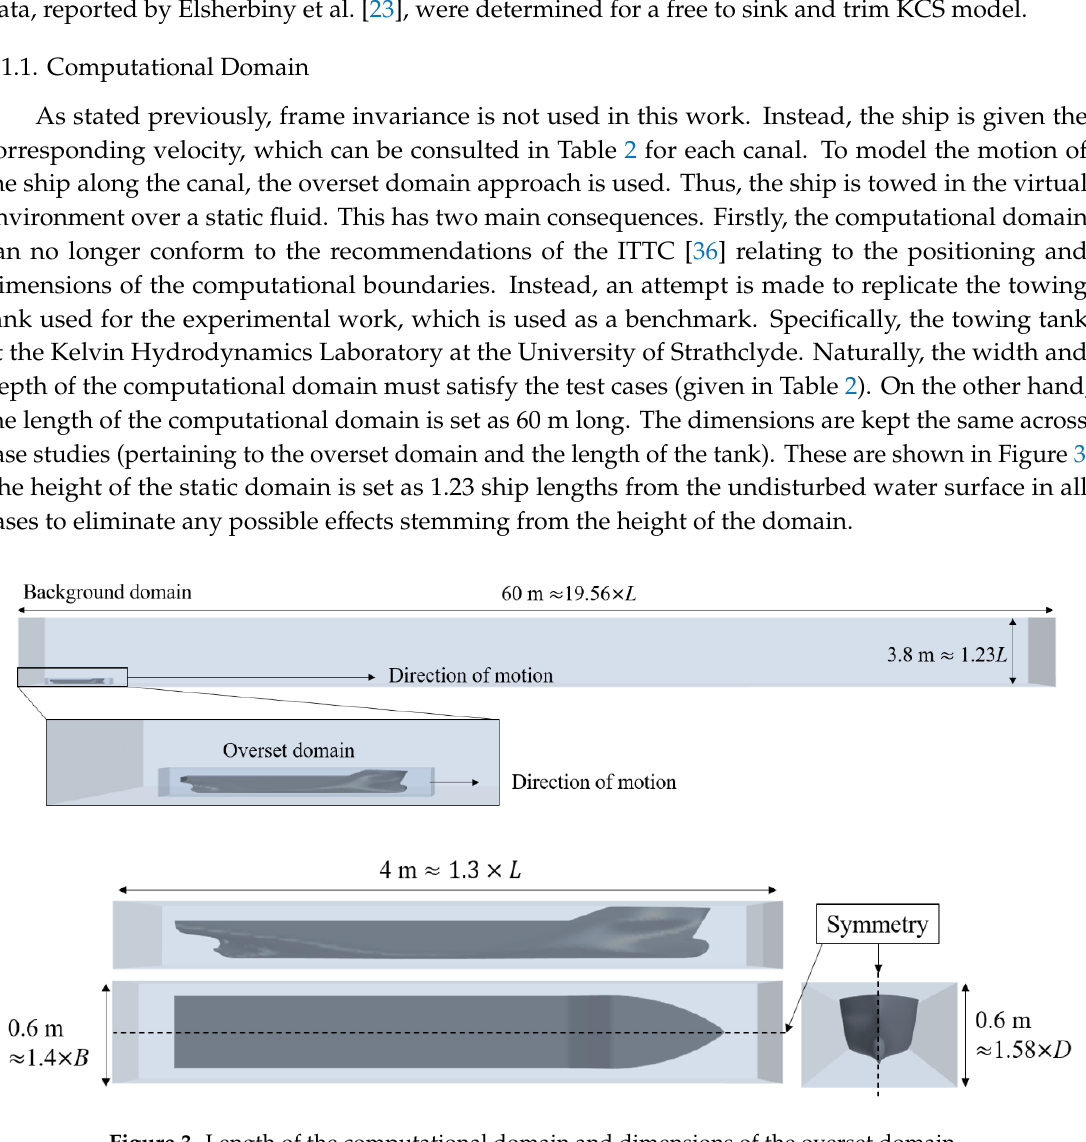
Figure 3. Length of the computational domain and dimensions of the overset domain.